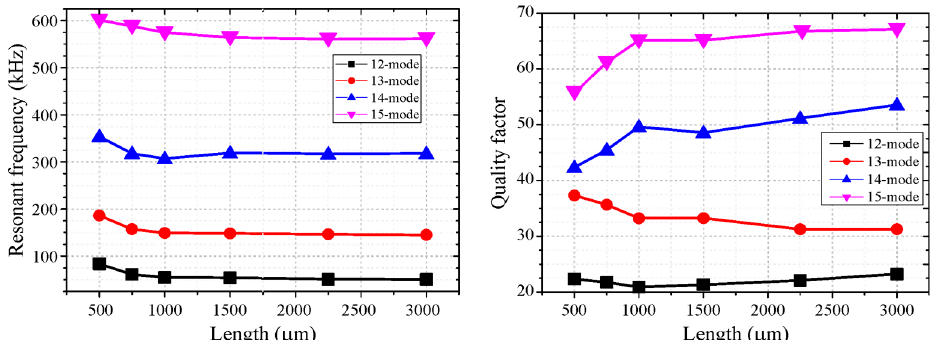
Figure 6. Resonant frequencies and quality factors for the first four roof tile-shaped modes in cantilevers with different lengths, and constant width and thickness of 900 µm and 20 µm, respectively. Values were deduced from the electrical impedance measurements in isopropanol.